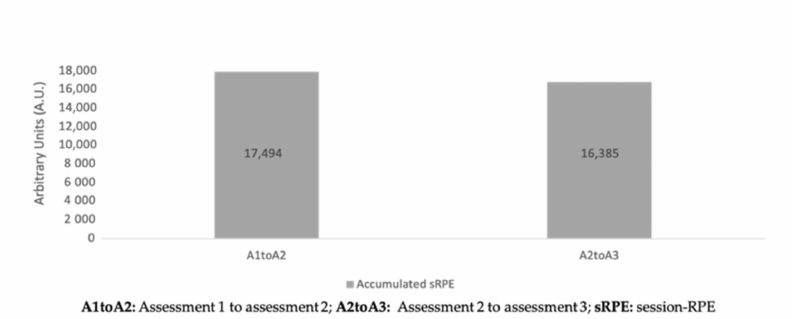
Figure 5. Accumulated sRPE during the periods of the